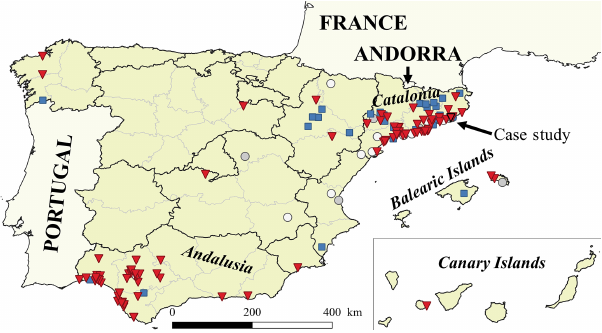
Figure 1. Location of 136 analysed events in Spain using the pro- posed methodology between 2004 and 2018, mostly concentrated in Andalusia and Catalonia. Symbols indicate locations of tornadoes (red triangles), downbursts (blue squares), undetermined phenom- ena (grey circles) and other phenomena such as gust fronts, funnel clouds which did not touch down or dust devils (white circles). The case study location for which final deliverables are attached as the Supplement is indicated on the map. Black contours delimitate re- gions and grey lines show